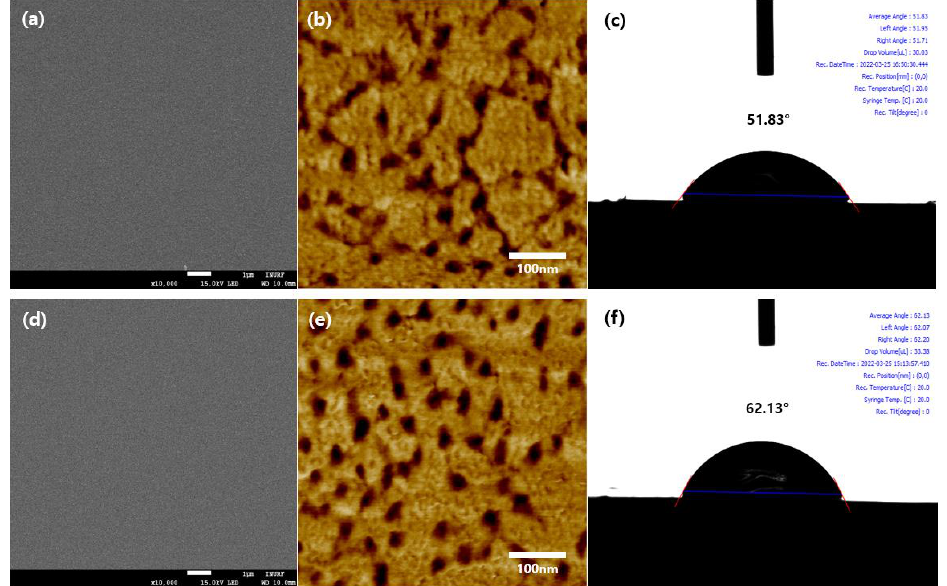
Figure 6. ( a ) SEM image, ( b ) AFM phase image, and ( c ) contact angle of x-TriPPO-50SEBS; ( d ) SEM image, ( e ) AFM phase image, and ( f ) contact angle of x-PPO-50SEBS.